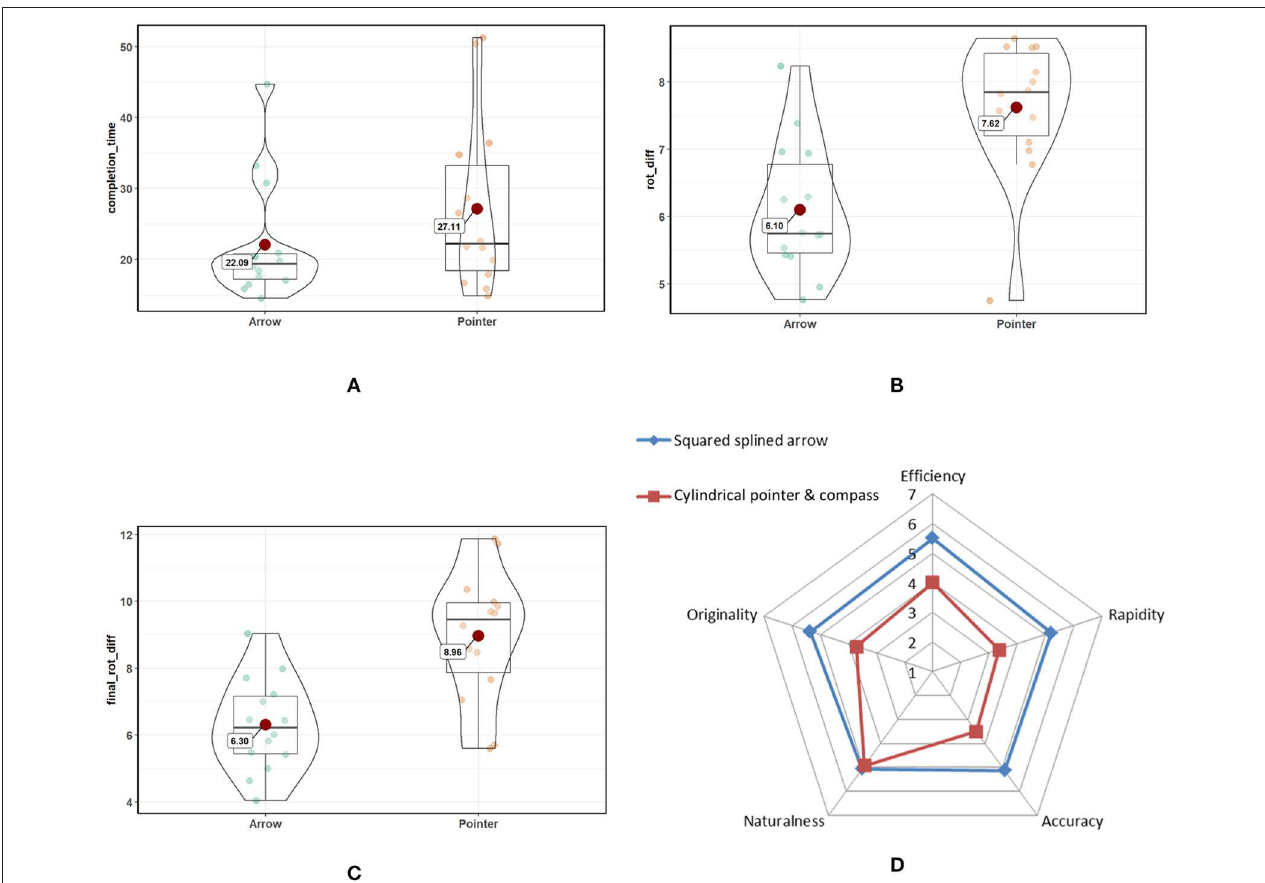
FIGURE 17 | (A–C) Boxplots of collected quantitative results; (D) summary of qualitative